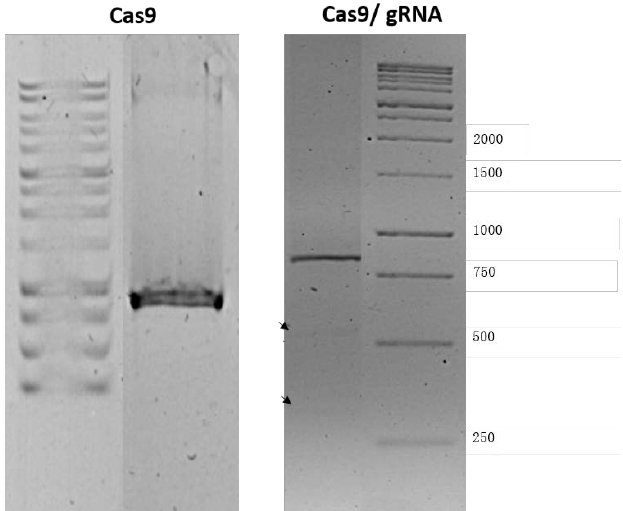
Figure 12. Gel electrophoresis analysis of in vitro ability of CRISPR pDNA delivered by alginate nanoparticles to induce double-strand breaks (DSBs) of targeted DNA. ( left ) PCR amplicon of GFP pDNA delivered to cells treated with Cas 9 only; ( right ) PCR amplicon of EGFP pDNA delivered to cell treated with (CRISPR ALG NPs). Black arrows indicate the new bands results from pDNA